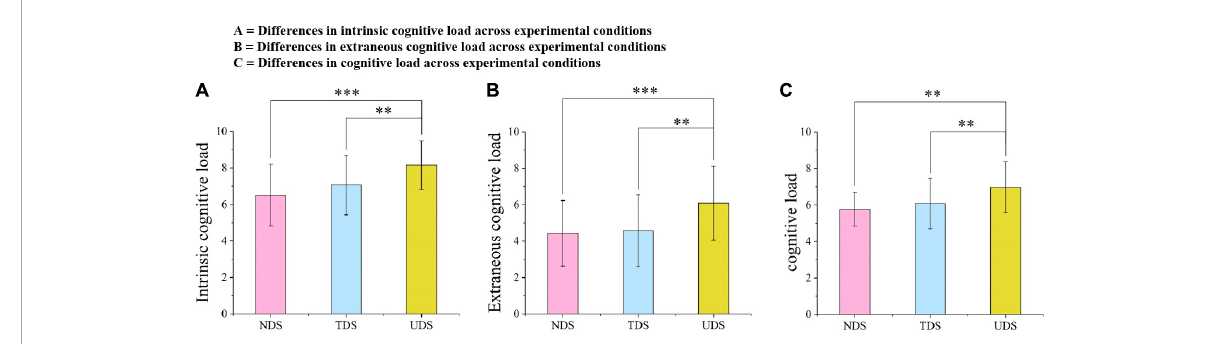
FIGURE5 Differences in cognitive load across the experimental conditions. (A) Differences in intrinsic cognitive load across experimental conditions; (B) differences in extraneous cognitive load across experimental conditions; and (C) differences in cognitive load across experimental conditions. ∗∗ p < 0.01, ∗∗∗ p < 0.001.